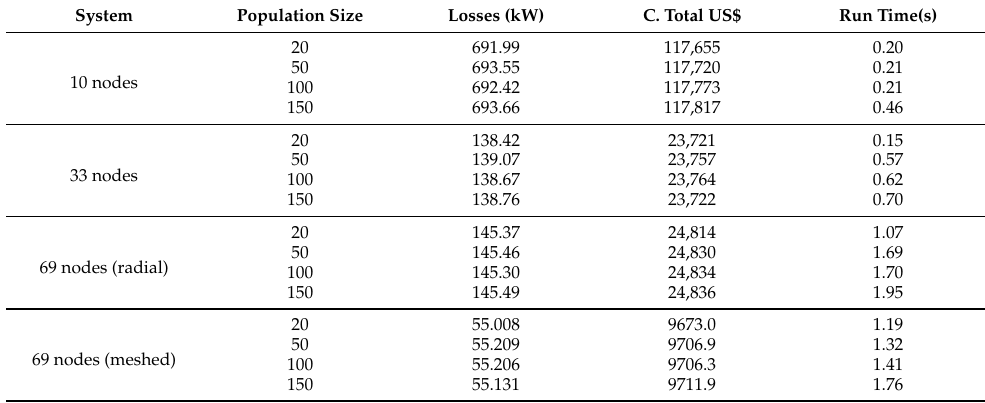
Table 13. Relation between population sizes, processing times, and objective functions.